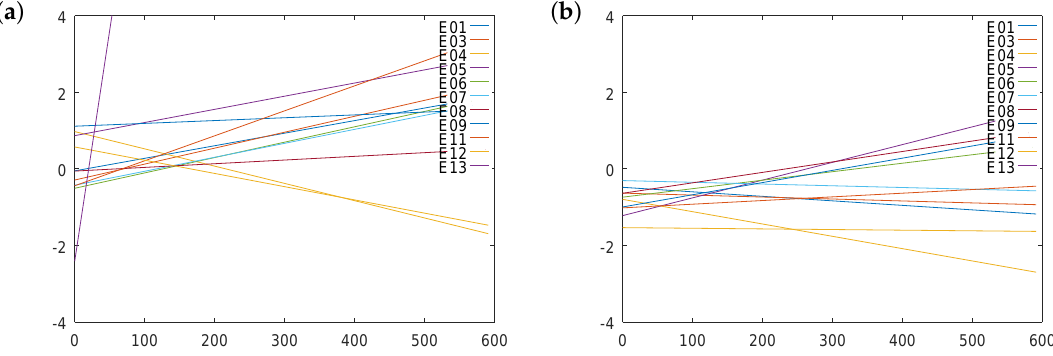
Figure 12. Illustration of dependence of hysteresis effect on electrode potential: ( a ) at 4 pH; and ( b ) at 9